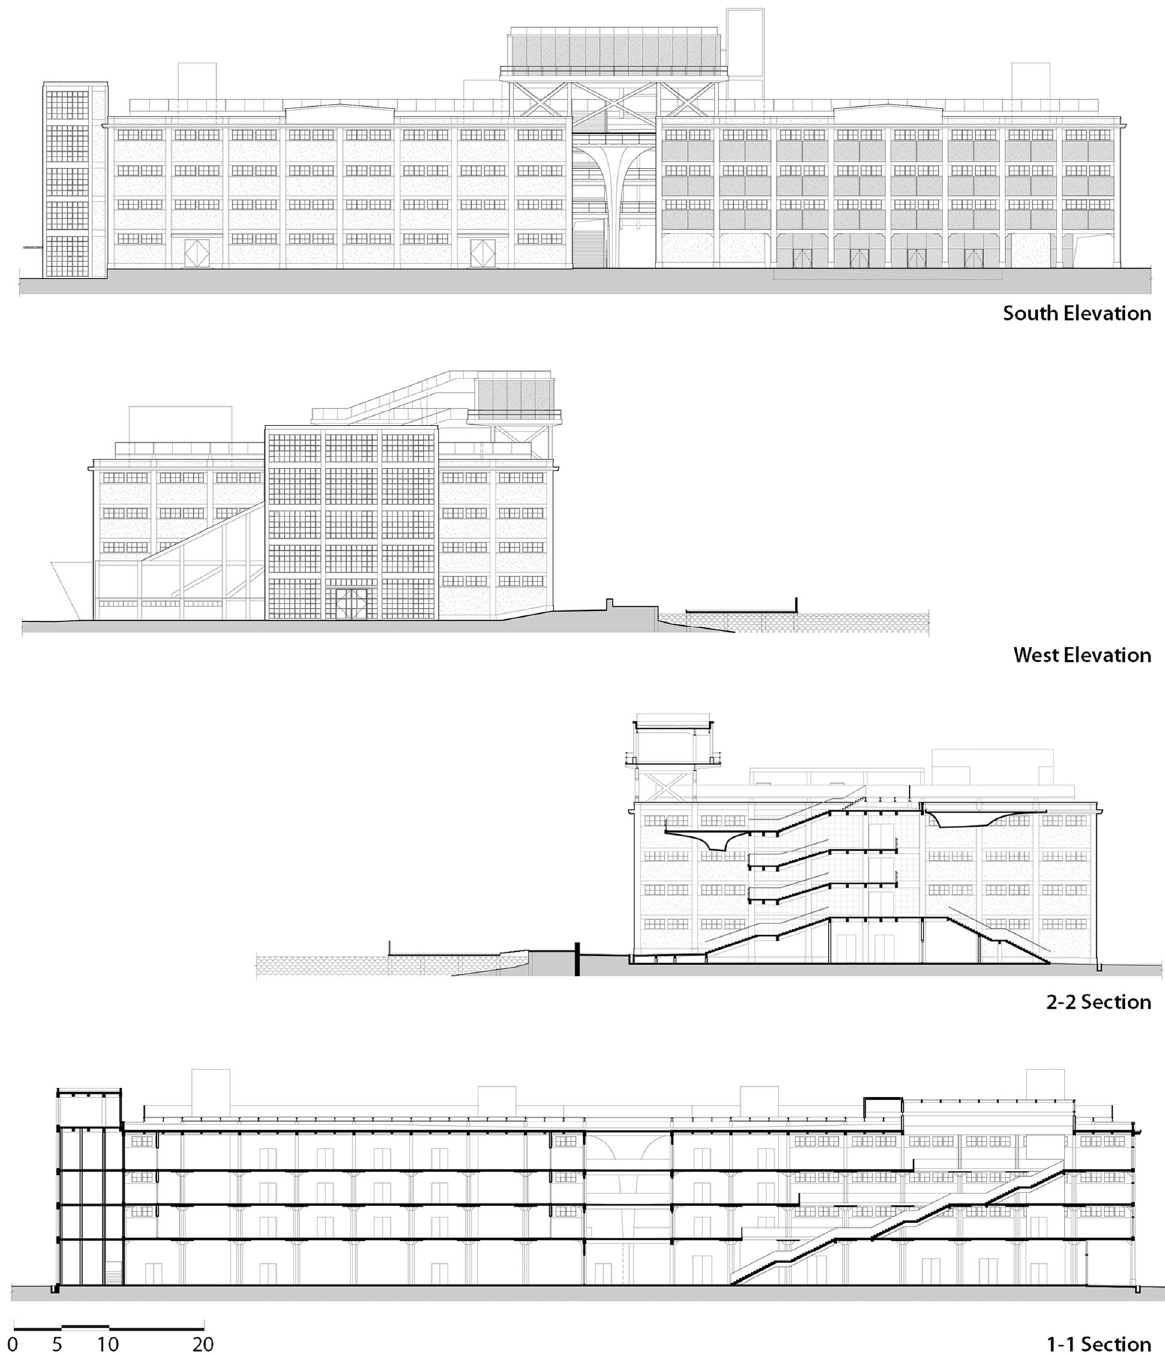
Fig. 20 Elevation and Section Drawings of the Yong ’ an Warehouse renovation (Source: Archi-Union